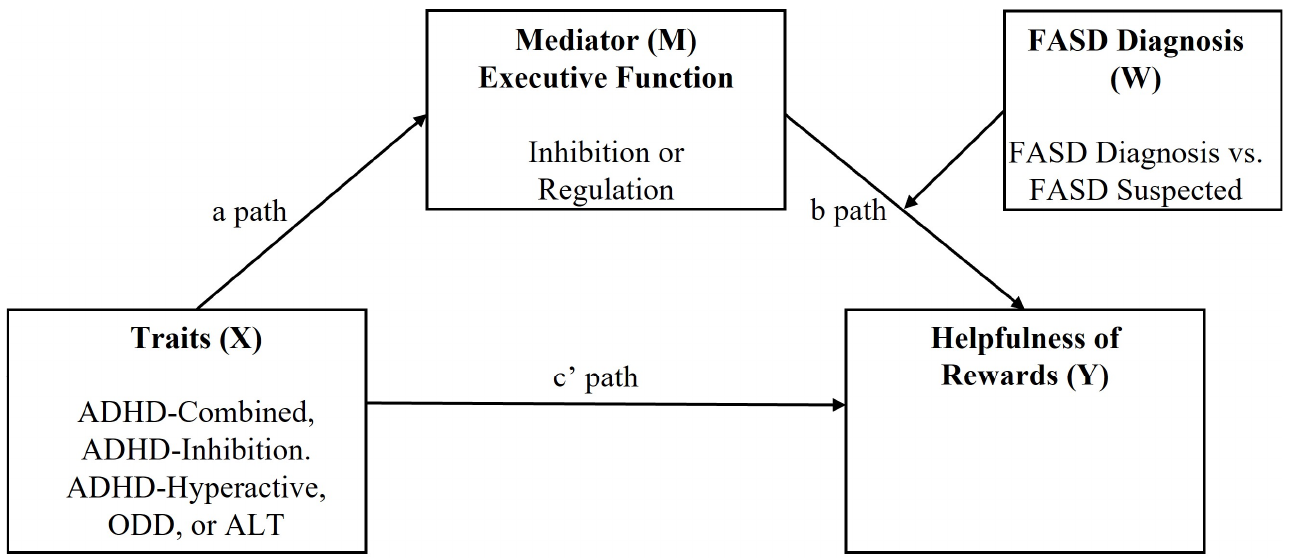
Figure 1. Hayes Model 14: Moderated Mediation Model .